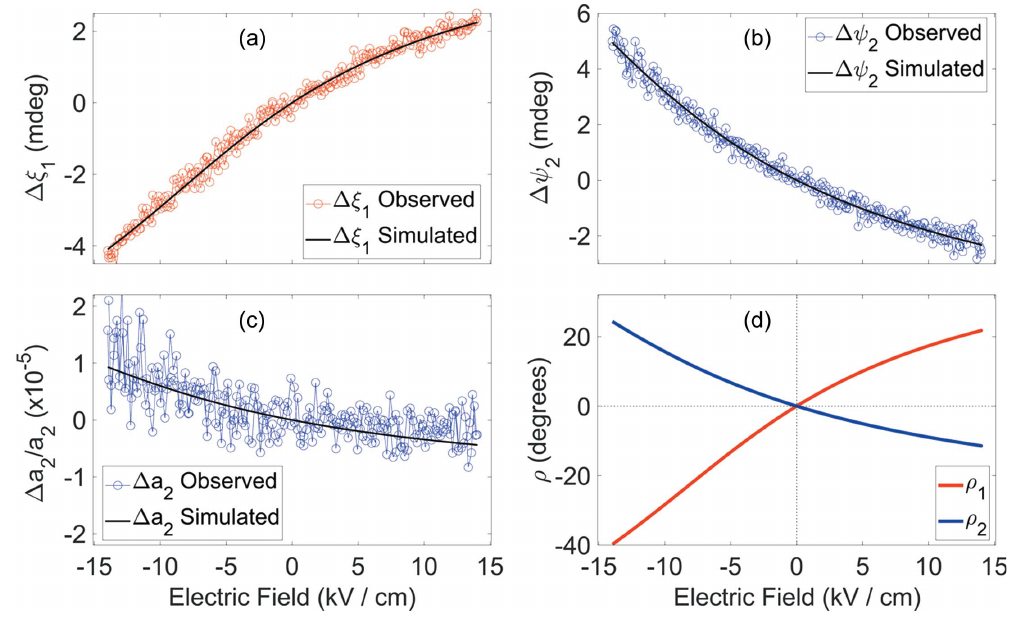
Figure 7 Electric field dependence of the strain parameters and polarization rotation angle. ( a )–( c ) Comparison between the observed change in the monoclinic strain parameters (cid:3) (cid:9) 1 , (cid:3) 2 and (cid:3) a 2 (circles) and the calculated change according to equations (15)–(17). ( d ) The polarization rotation angles (cid:10) 1 and (cid:10) 2 , as defined in Fig. 5( b